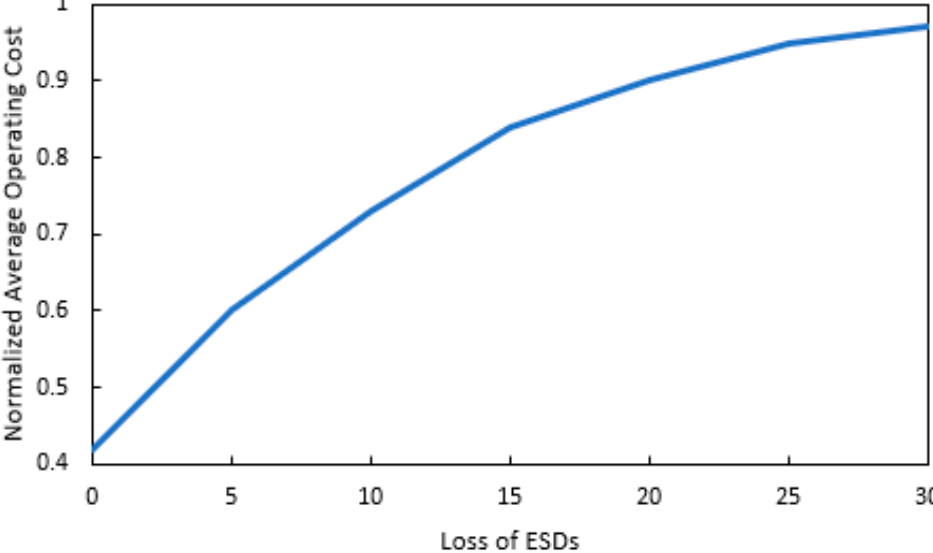
Figure 7. Impact of energy storage devices on the average operating cost of the DC .